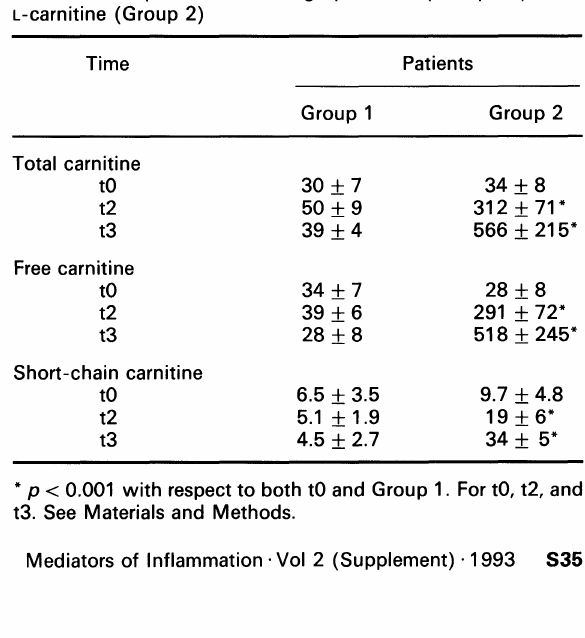
Table 2. Total, free, and short-chain carnitine (nmol/ml) in serum from patients receiving placebo (Group 1) and